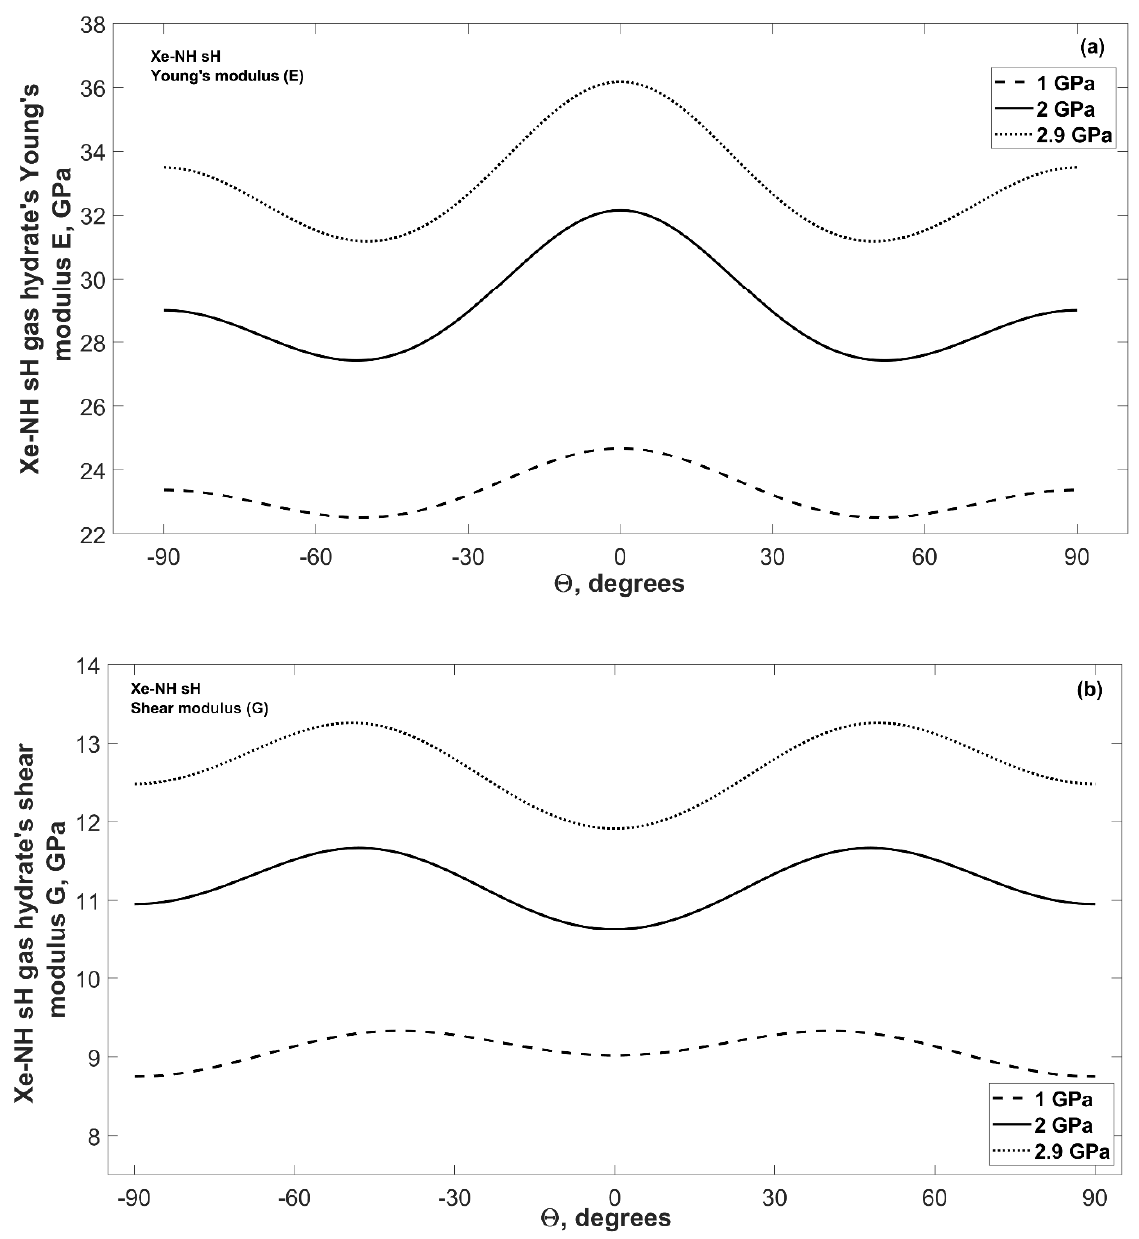
Figure 8. Direction-dependent Young’s E ( a ) and shear G ( b ) moduli of Xe-NH sH gas hydrate at different pressures and 0